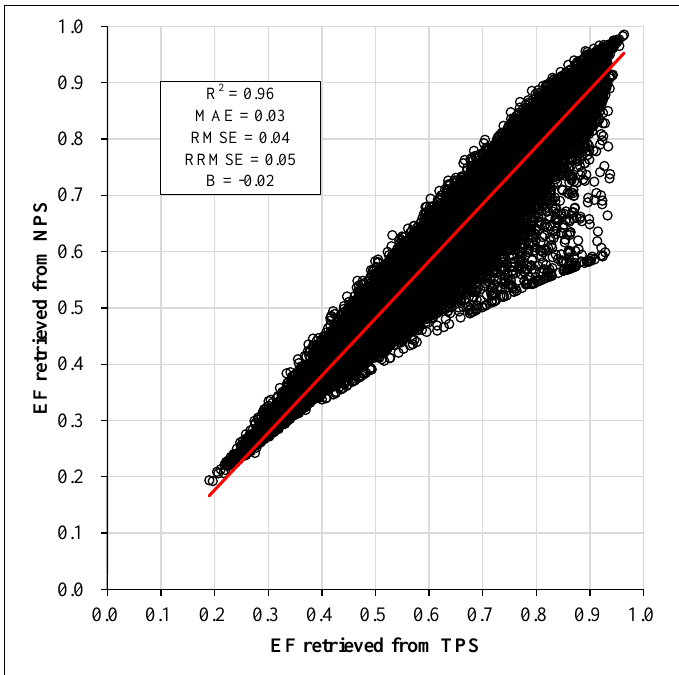
Figure 9. Contrast of EF retrieved from TPS and NPS over the whole SGP region on DOY 239.